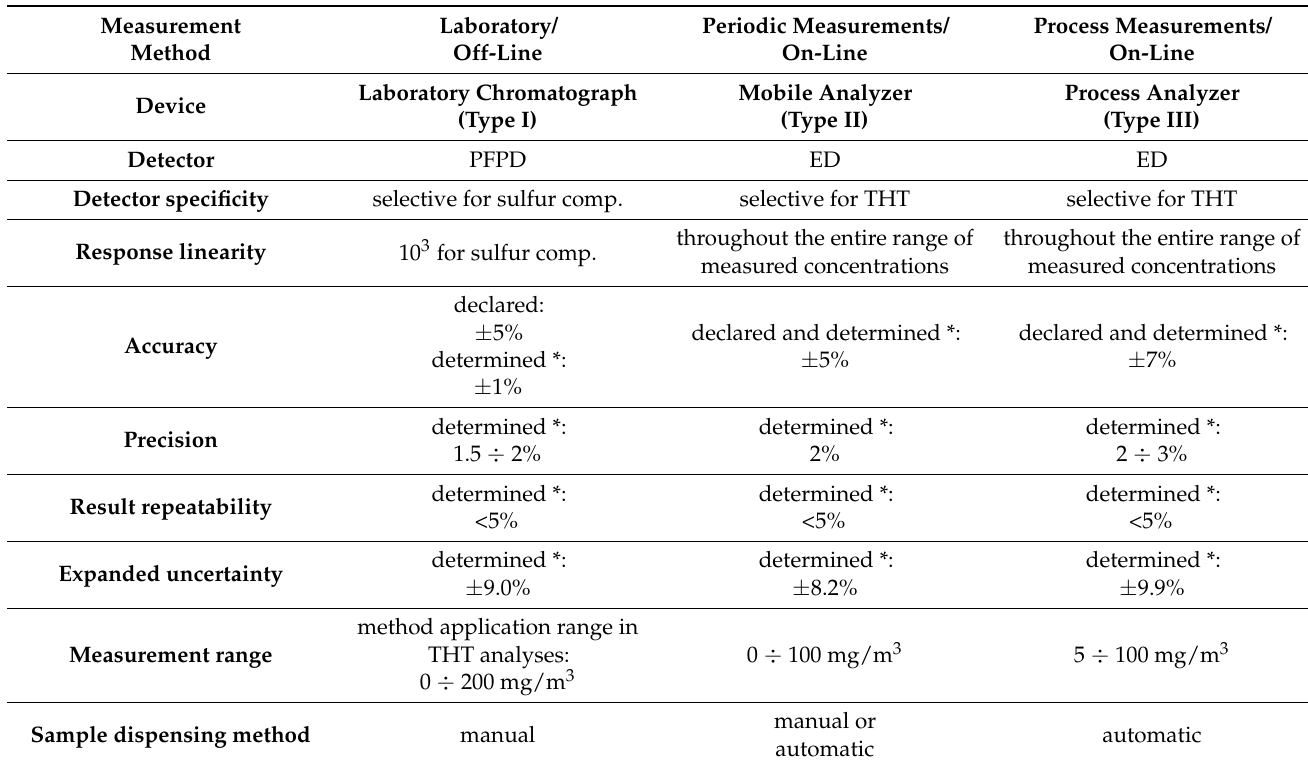
Table 3. Parameters of devices used in Poland for chromatographic measurement of THT concentra- tion in distribution gas